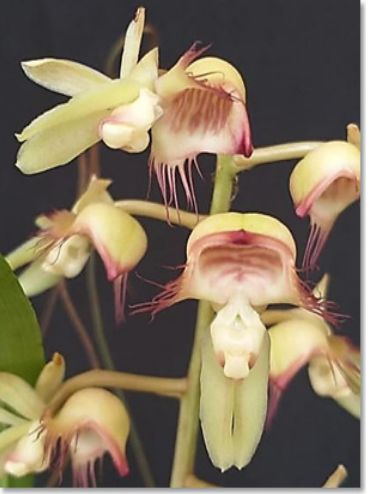
Figure 7. Catasetum ciliatum . (Source Luiz Otavio Ad ã o).